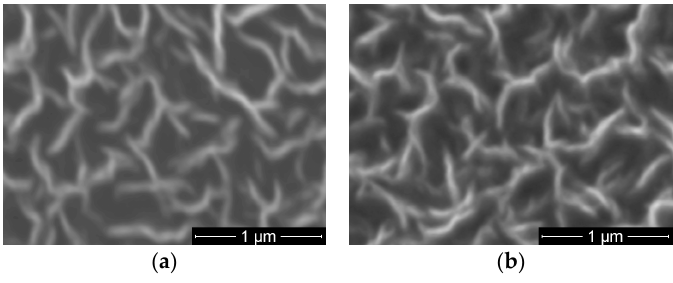
Figure 10. SEM images of CNW treated with SF 6 plasma for ( a ) 8 sccm; and ( b ) 36 sccm.